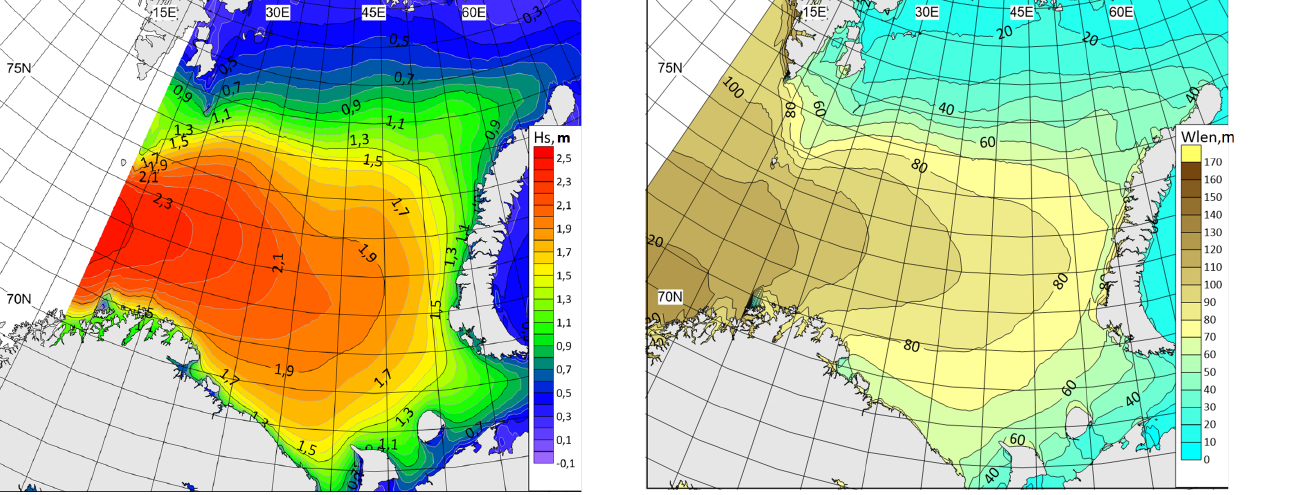
Figure 4. Long-term average significant wave height in the Barents Sea based on the WWIII simulation results for the 1979–2017 pe- riod.